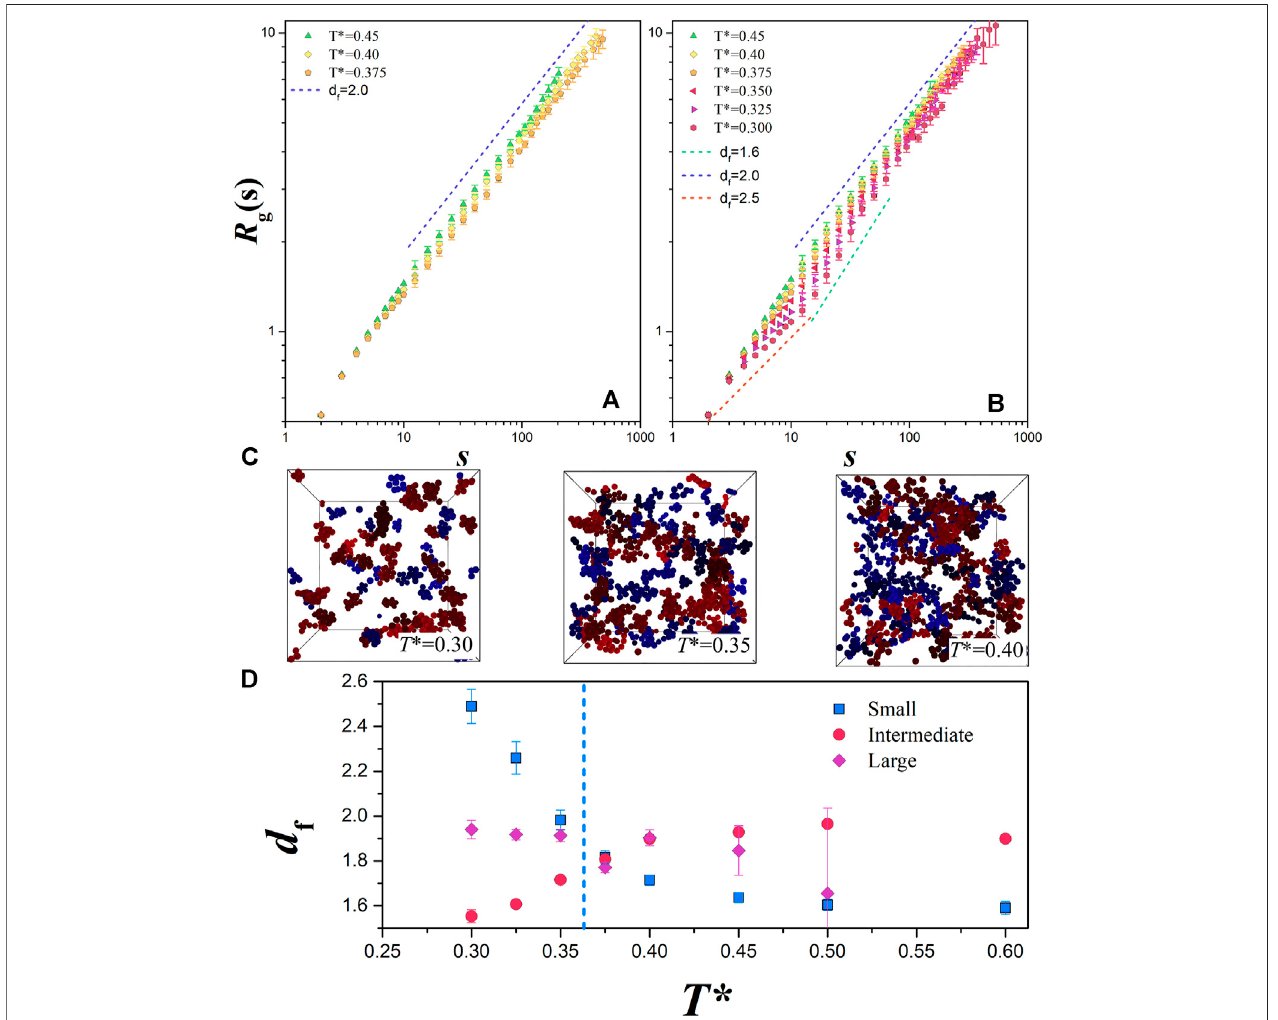
FIGURE4| Radius ofgyration for competing interaction systems at ϕ (cid:2) 0 . 1with different repulsion strengths (A) A (cid:2) 0 . 5and (B) A (cid:2) 1 . 0at different temperatures. Weplot,alongtheexpected R g ,theradiusofgyrationforclusterswithafractaldimensionof2(bluelines),2.5(redlines)and1.6(greenlines). (C) Snapshotsofthesystem with A (cid:2) 1 . 0 at different temperatures are displayed. Clusters with 5 up to 12 particles are colored in blue and clusters with 15 ≤ s ≤ 30 in red. (D) Fractal dimension for systems with A (cid:2) 1 . 0, we classify clusters in small ( s ≤ 12), intermediate (13 ≤ s ≤ 60) and large ( s ≥ 100), see [40]. Vertical line is the boundary between dispersed and clustered fl